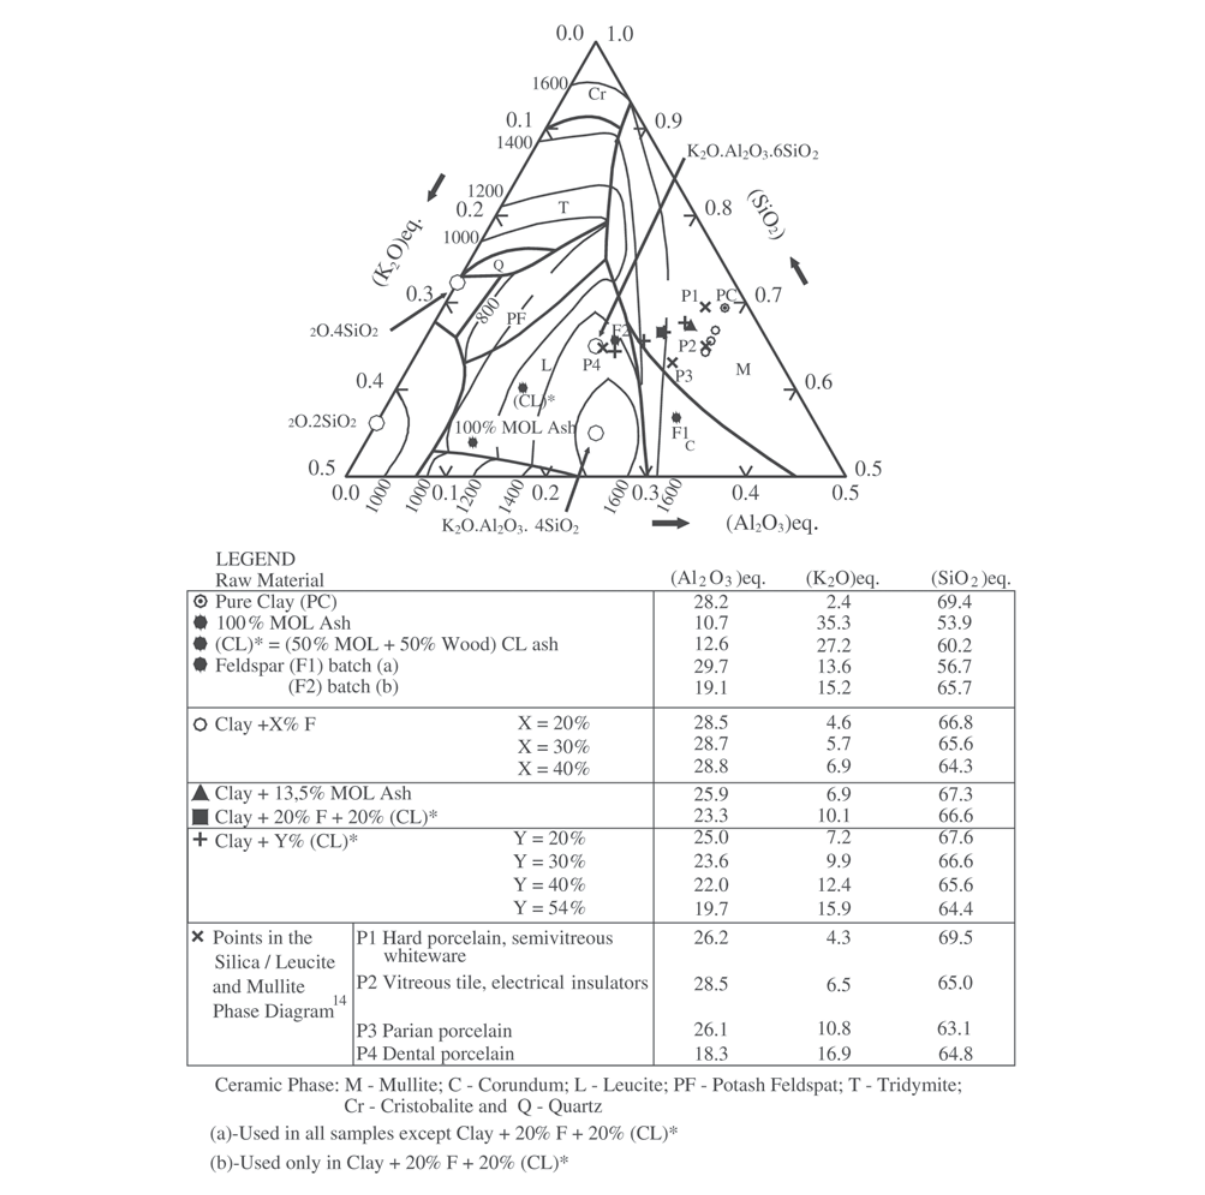
Figure 7 . Equivalent composition for some ceramics and some points of the Σ (SiO phase